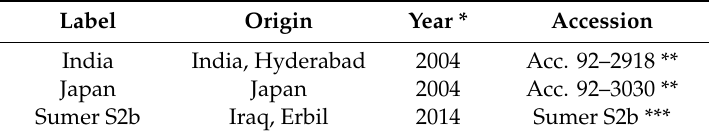
Table 2. Sesamum indicum